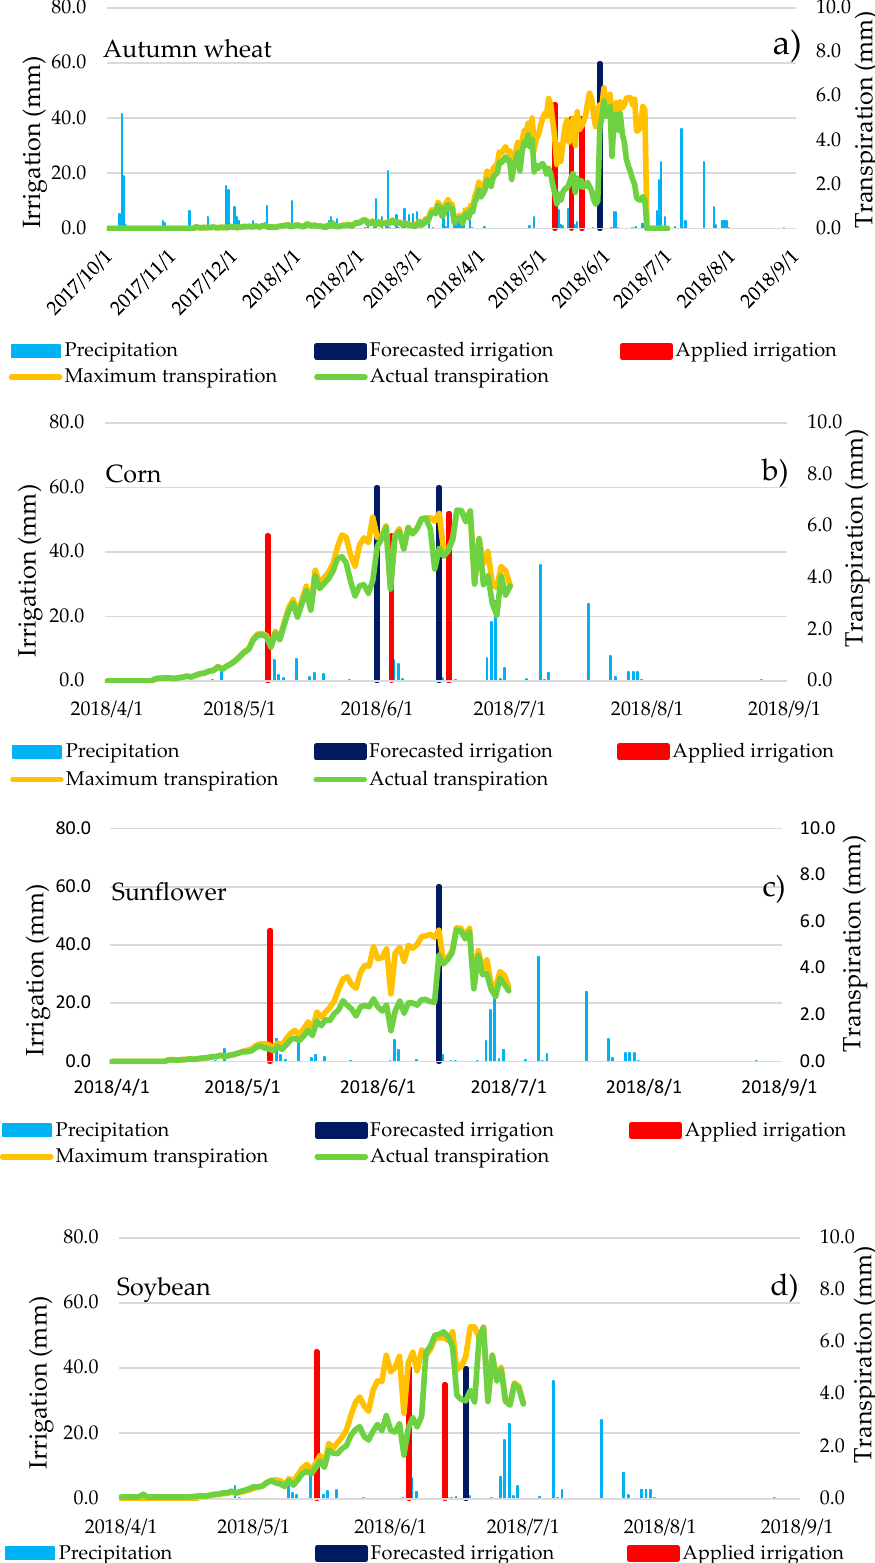
Figure 7. Forecasted irrigation vs applied irrigation for autumn wheat ( a ), corn ( b ), sunflower ( c ) and soybean ( d ).